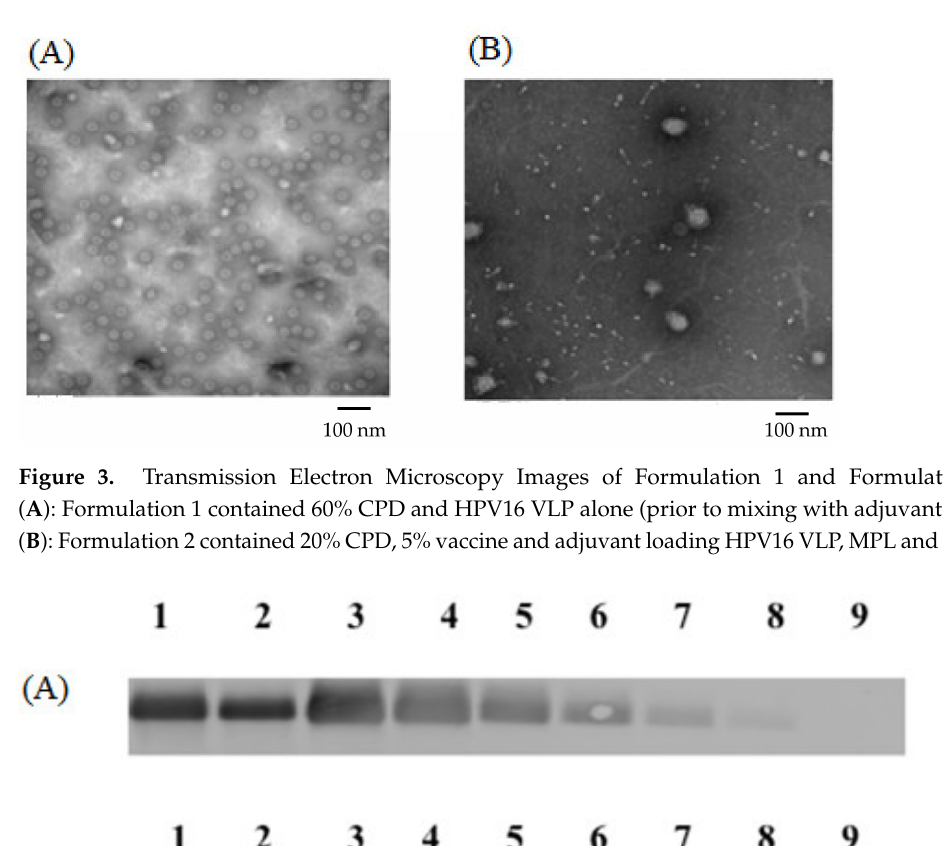
Figure 4. Western blot images of Formulations 1 and 2. ( A ): Formulation 1. Lane 1, 2: HPV16 VLPs in MPs (1.0 and 0.5 μg), Lane 3, 4, 5, 6, 7 and 8: blank MPs + HPV 16 VLPs in solution (1.0, 0.5, 0.25,